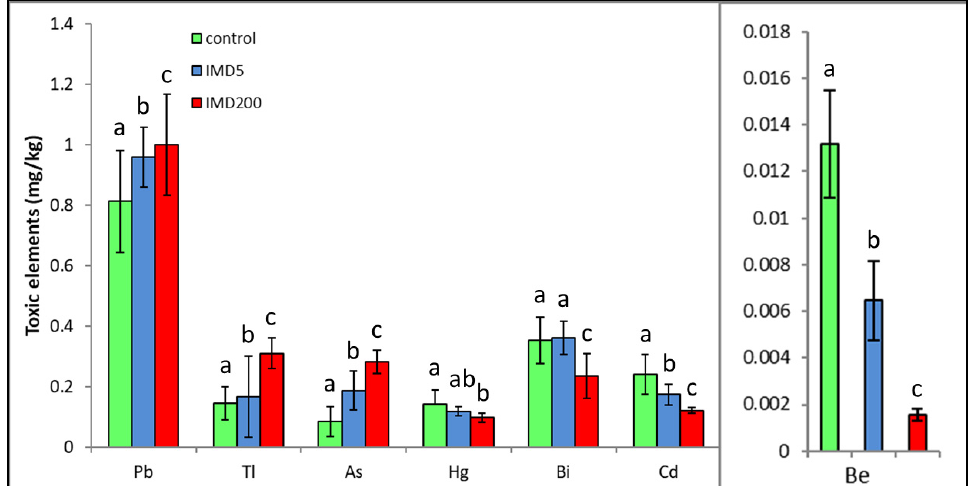
Figure 5. Body levels (mean ± SD) of the exclusively toxic bioelements in honey bee workers exposed and unexposed to imidacloprid. Explanations: control = the bees were fed a diet without imidacloprid; IMD5 = the bees were fed a diet with a 5 ppb addition of imidacloprid; IMD200 = the bees were fed a diet with a 200 ppb addition of imidacloprid. Different lowercase letters = differences between the means nested within each bioelement are significant (ANOVA + LSD; p < 0.05).